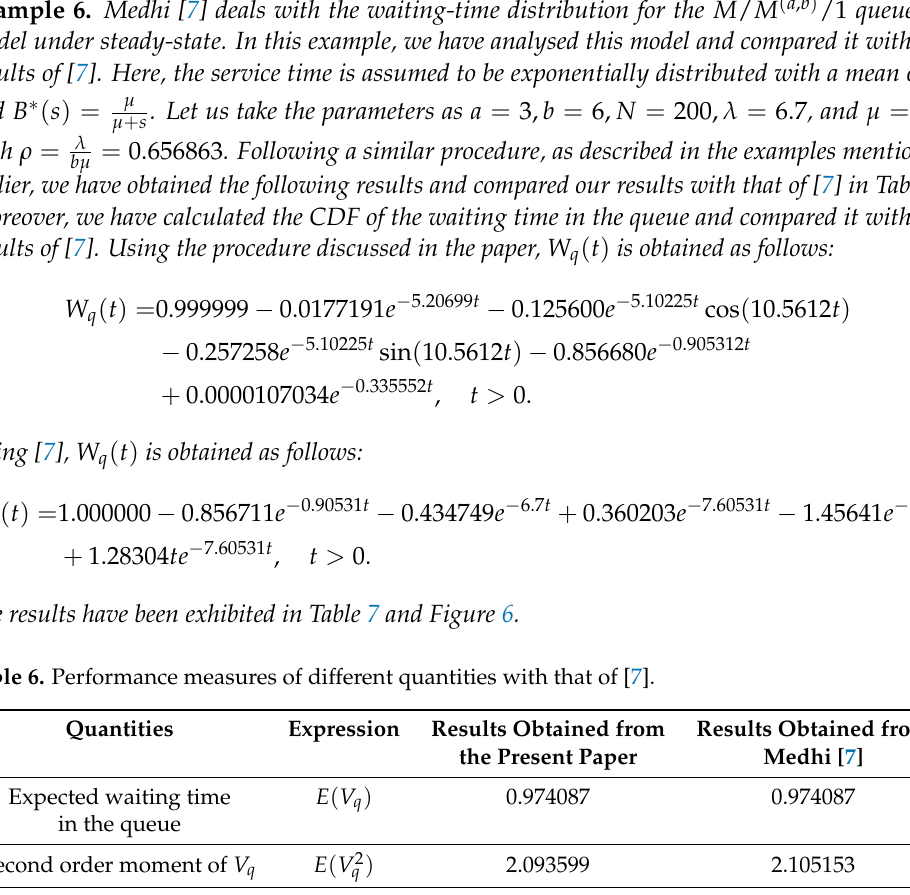
Figure 5. Buffer size ( N ) versus mean sojourn time ( E [ V ] ) and N versus loss probability ( P loss ).